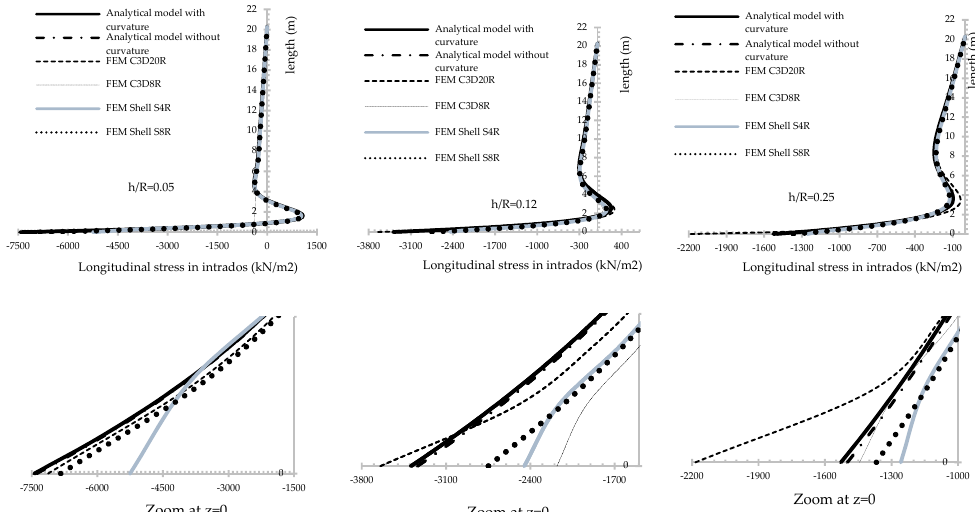
Figure 10. Longitudinal stress in intrados for thin, medium and thick shells, considering different models.